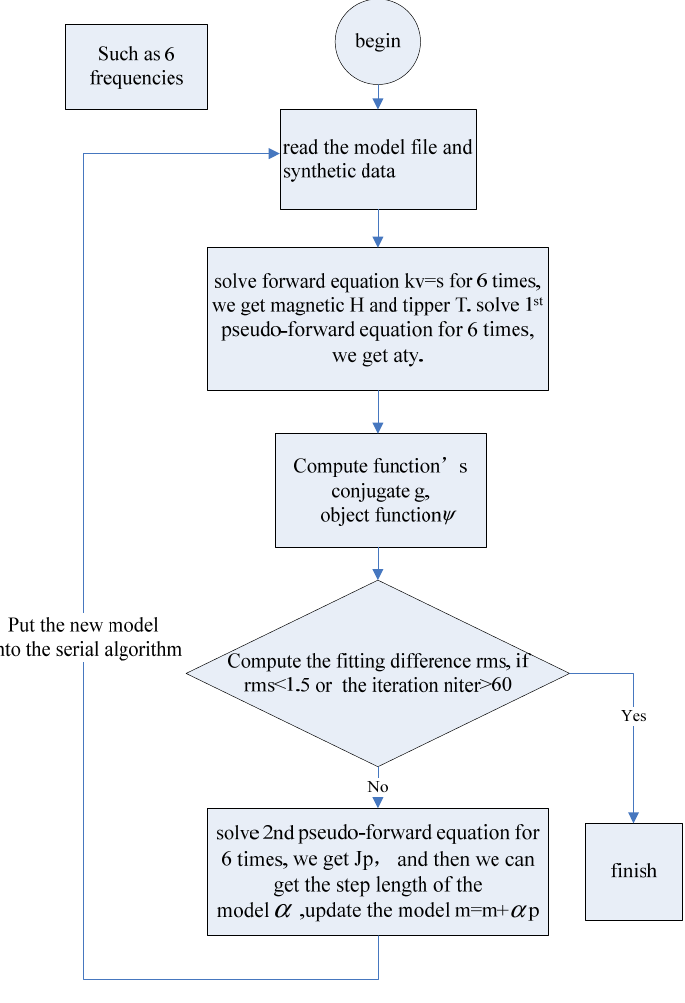
Figure 1. The flow chart of inversion.